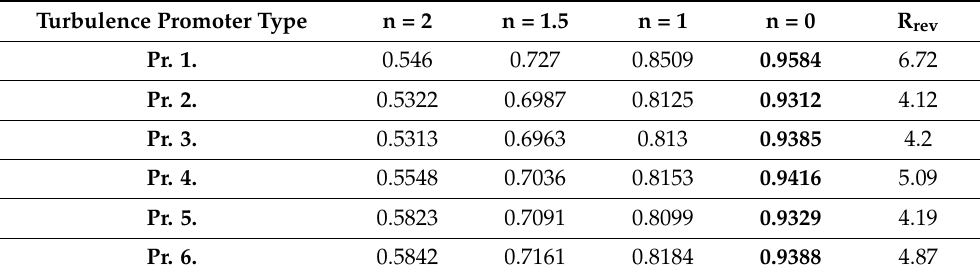
Table 5. R 2 values of Hermia model and reversible resistance ( NMWL = 150 kDa).